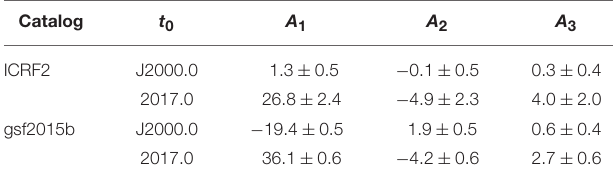
TABLE 2 | Impact of galactic aberration on the orientation angles between the ICRF and GCRF. Catalog